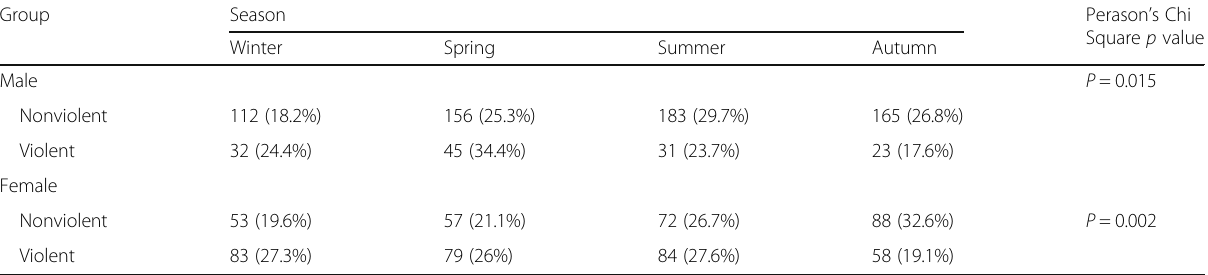
Percentages calculated across row, Season defined according to Coimbra et al.